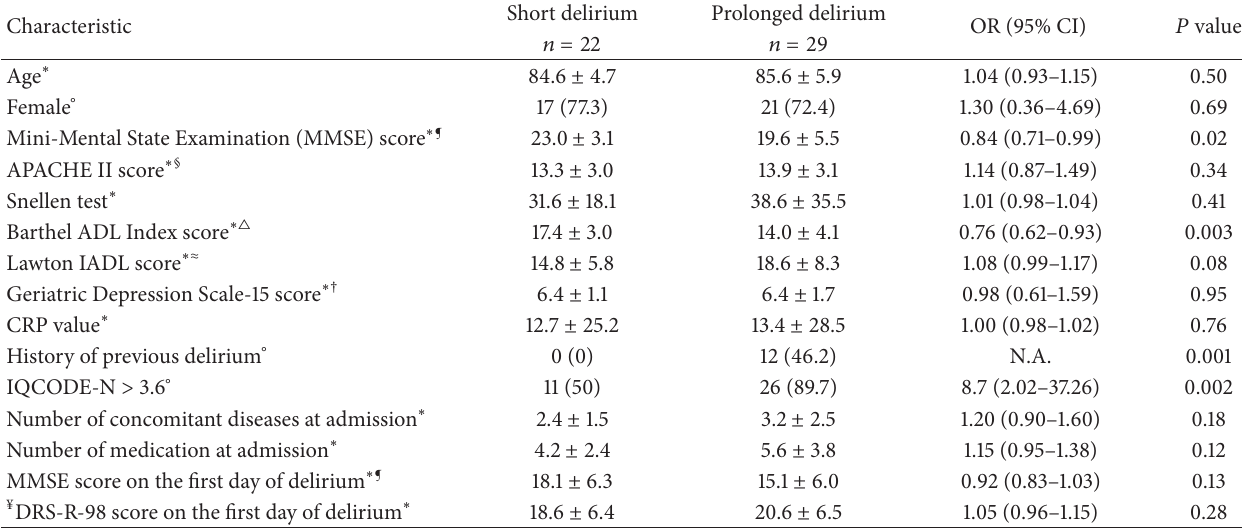
Table 1: Baseline clinical and demographic characteristics of patients in the short and prolonged delirium group. Characteristic